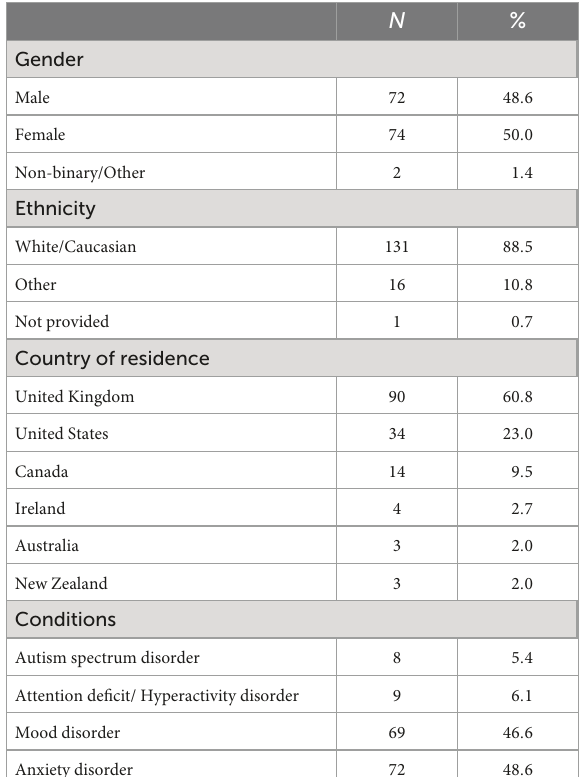
TABLE 1 Participant